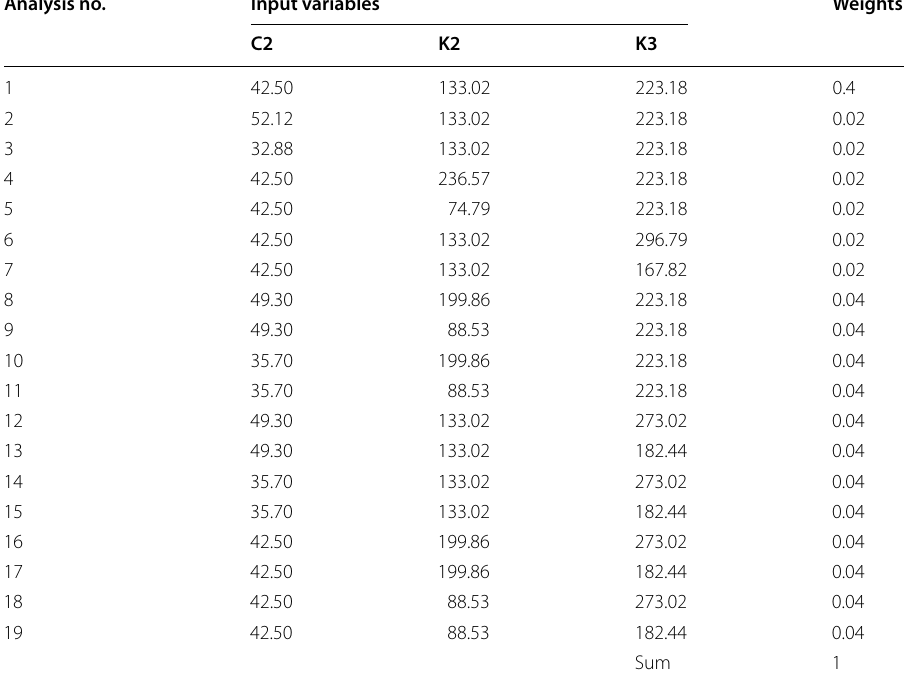
Table 5 Sampling points and assigned weights to basic variables of deformation analysis (i.e., C2, K2 and K3) in PEM Analysis